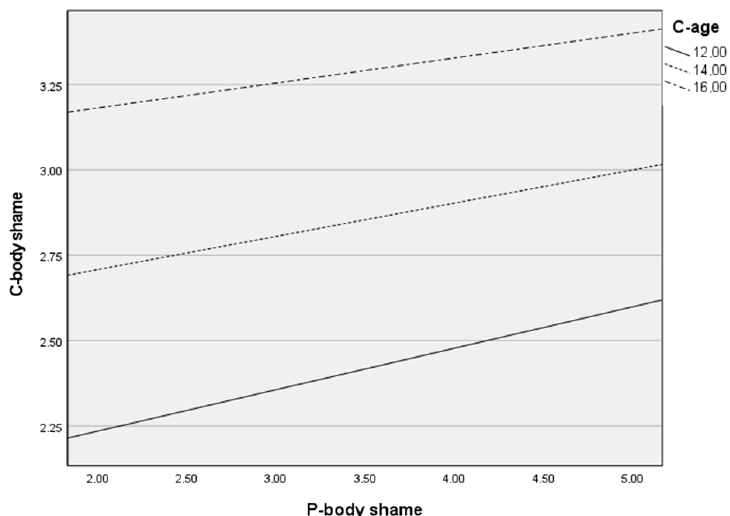
Figure 2. Moderation analysis: the effect of parent body shame (P-body shame) on child body shame (C-body shame) by child age (C-age) among the Italian sample.